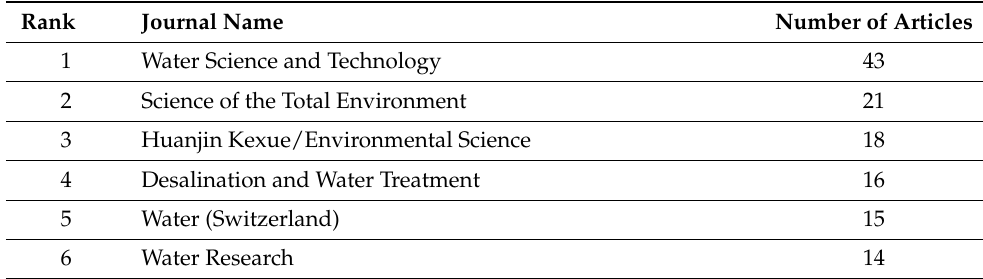
Table 1. The number of documents per journal for the keyword search “first flush” or “stormwater” or “storm water” or “runoff” and